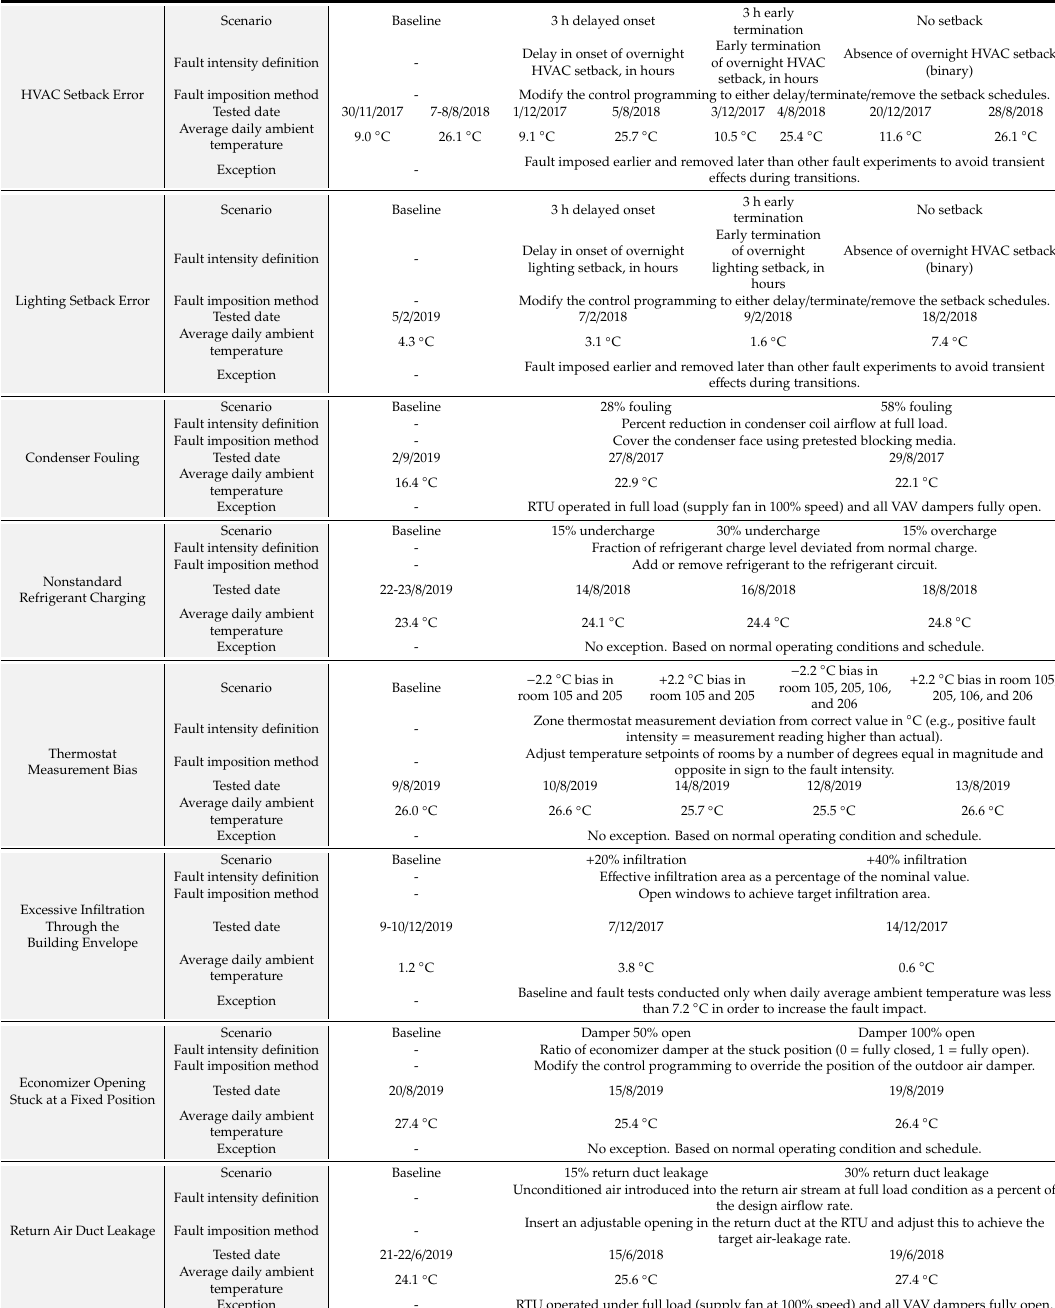
Table A1. Experimental configurations for all fault